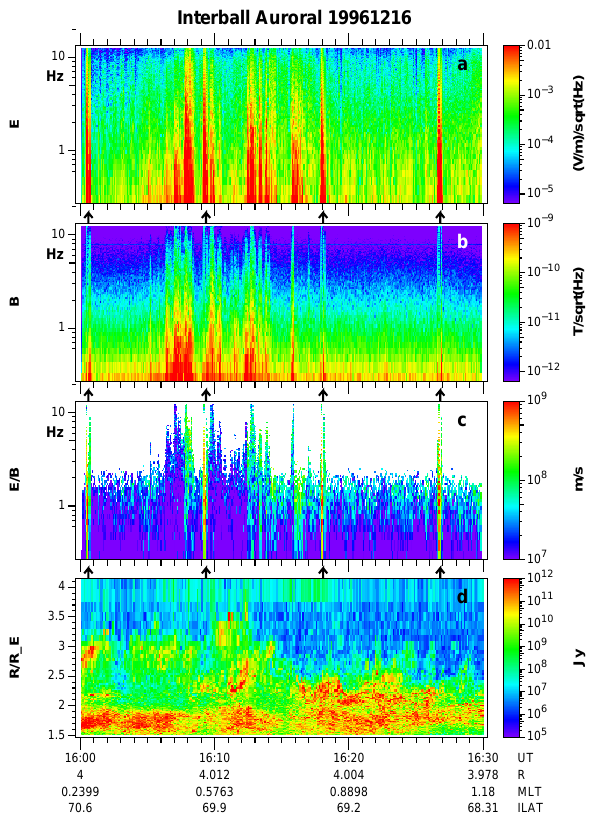
Fig. 9. Same as Fig. 8 but for 16 December 1996. Here the magnetic amplitude of the low-frequency waves is stronger than in the 11 December event (Fig. 8) and, consequently, the E/B ratio (panel (c)) is smaller. Therefore, the correspondence between waves and dot-AKR is most easily seen by comparing panels (b) (magnetic amplitude) and (d) (dot-AKR). The dot seen at 16:12–16:13 at 3- 3.6 R E radial distance (30–50kHz) occurs (partly) simultaneously with low-frequency waves, while the dot at 16:00–16:03 does not. Again, because AKR can propagate from remote sources, perfect correlation is not